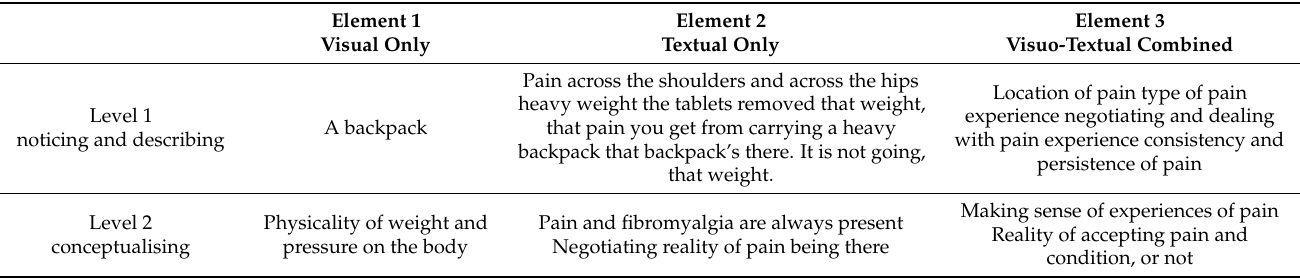
Table 3. Example of Systematic Visuo-Textual Analysis applied to Bernie’s data.